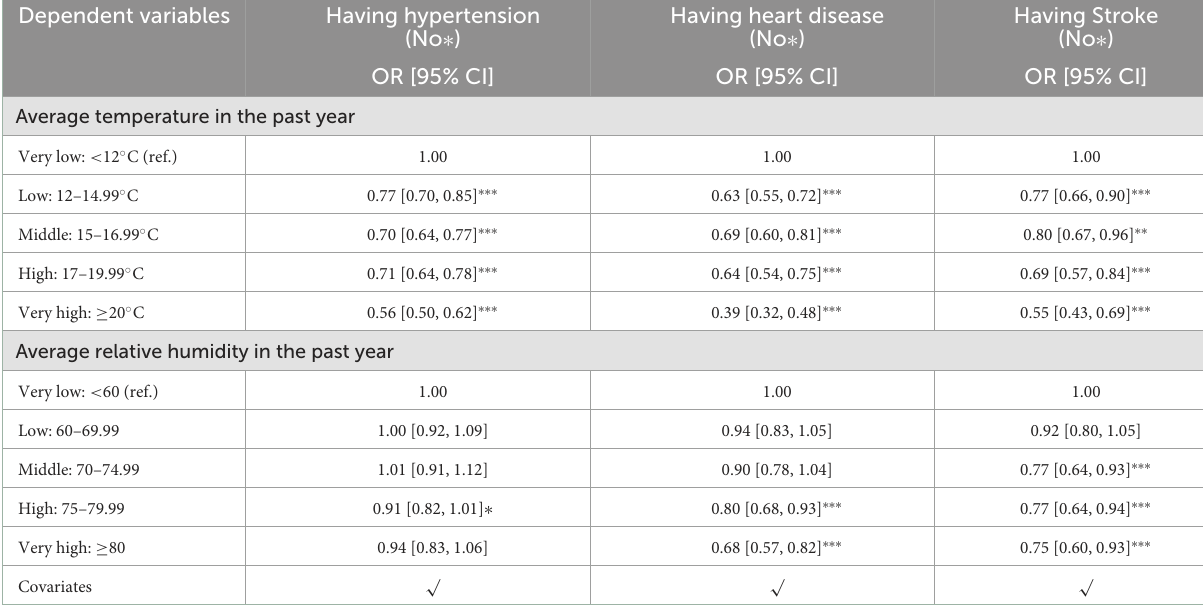
TABLE 5 Effects of categorical temperature and relative humidity on CVD: Odds ratios (OR) from hierarchical GEE models. Dependent